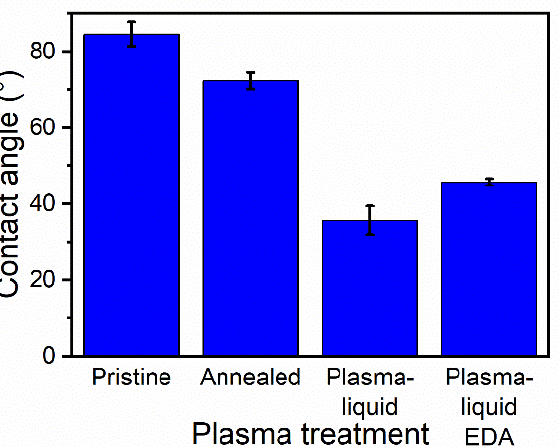
Figure 6. Summary of the contact angle measurement results for the 6 different carbon nanotube treatments.